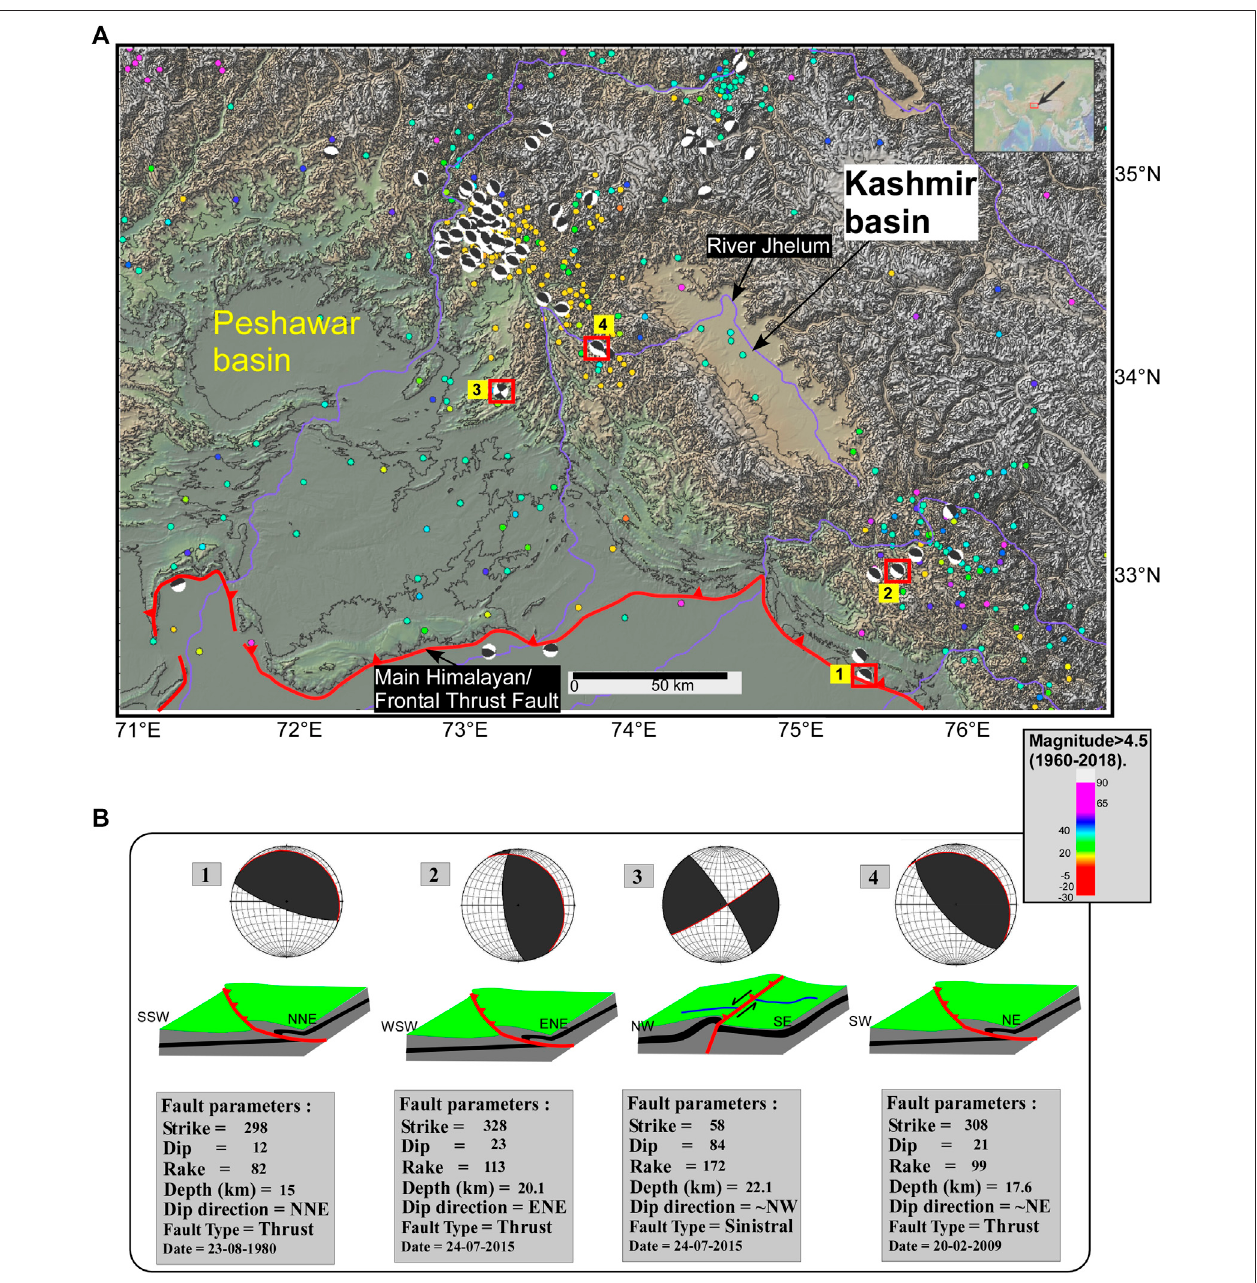
FIGURE 2 | (A) Regional topographic map with contours shows the intermontane basins (Kashmir and Peshawar) in NW Himalaya. Note the relatively higher elevation of Kashmir basin relative to Peshawar basin. The trace of the Himalayan megathrust fault (the Main Himalayan/Frontal Thrust) is shown in red line with teeth toward the hanging wall block. The colored dots are earthquake epicenters with a magnitude of > 4.5 (data are from 1960 to 2018). The earthquake moment tensor solutions, shown as beach balls, are also plotted, and these are clustered around the two corners of the Kashmir basin, which are mainly related to the 2005 Kashmir (in NW) and 1905 Kangra (in SE) events. (B) Shows the selected events that are used and correlated with the active faults in the region. Figure was made with data from GeoMapApp (www.geomapapp.org)/CC BY/CC BY (Ryan,